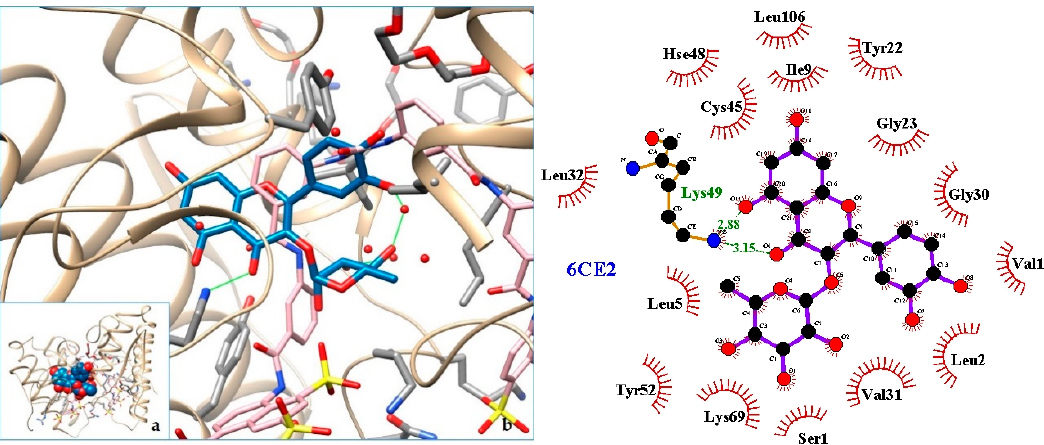
Figure 7. 6CE2-q uercetrin complex in the most favourable arrangement ( a ) and augmented ( b ) showing the disposition between the chain of toxins. Right: 2D interaction diagram.